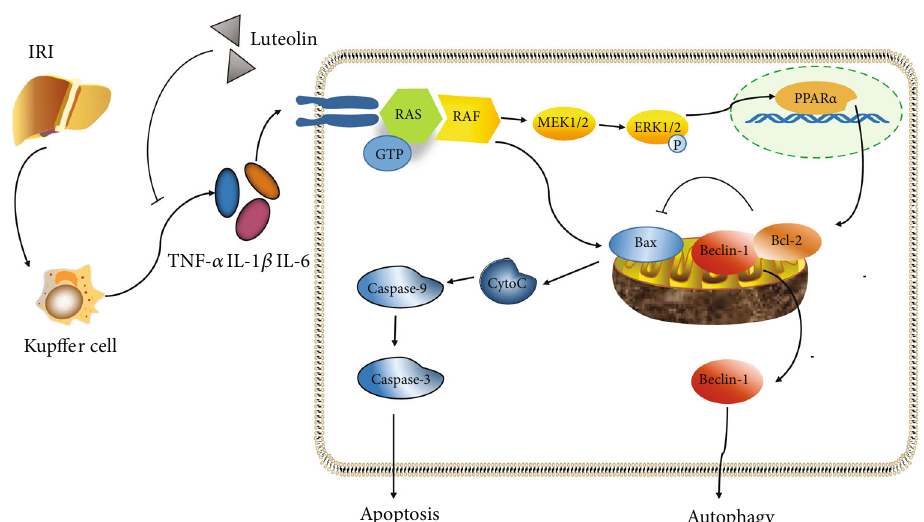
Figure 7: Probable mechanisms of luteolin against HIRI. Hepatic IR injury will activate Kup ff er cells, thus producing several in fl ammatory cytokines, including IL-1 β , IL-6, and TNF- α . Luteolin pretreatment can inhibit this process to alleviate liver injury. Luteolin can additionally regulate autophagy and apoptosis through ERK/PPAR α